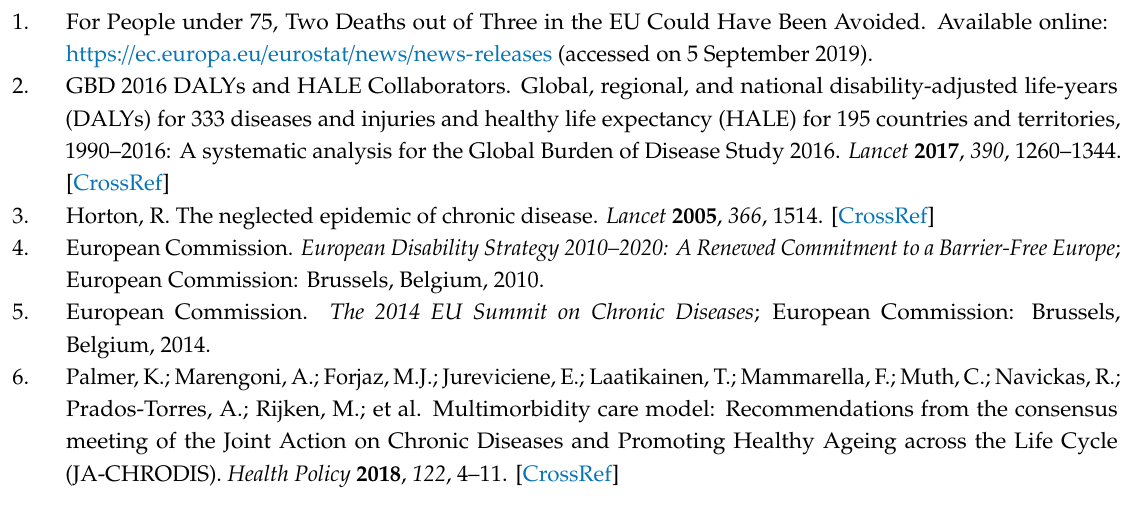
Table S1: Overview of the selected good practices on Health Promotion, Table S2. Seven recommendations for Intersectoral Collaboration with the rationale and steps to implement the recommendation and examples of the practices which show the recommendation in